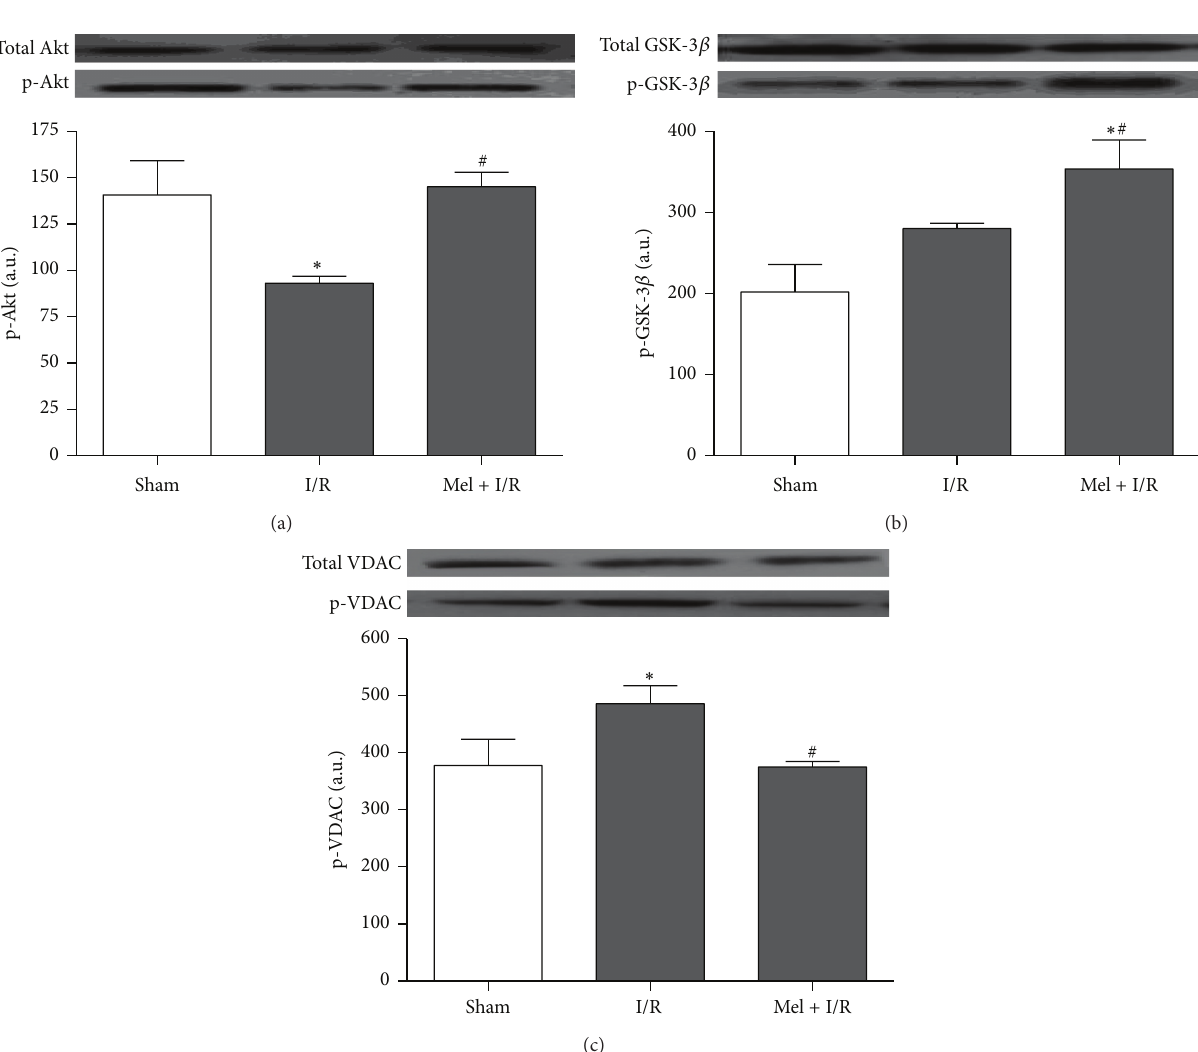
Figure 5: Western blot of total and phosphorylated Akt (a), total and phosphorylated GSK-3 𝛽 (b), and total and phosphorylated VDAC (c). One representative blot of six independent experiments is shown at the top whereas densitometric analysis is shown at the bottom. Results are expressed as mean ± SEM. ∗ 𝑝 < 0.05 versus Sham. # 𝑝 < 0.05 versus